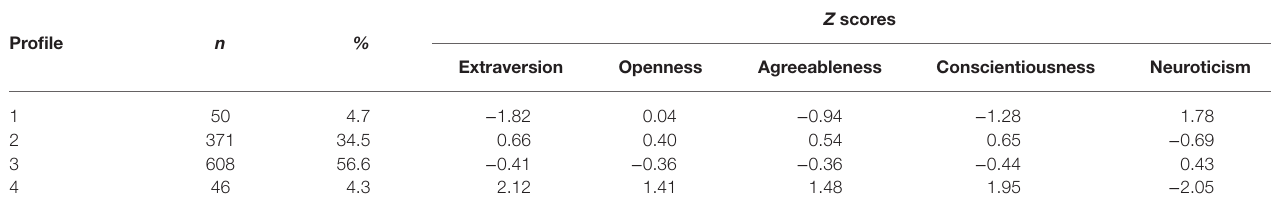
TABLE 3 | Statistical description of 4-profile